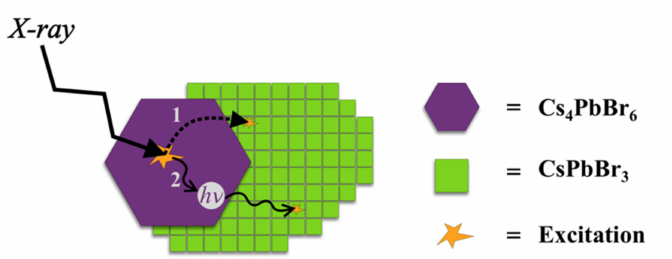
Figure 4. Schematic illustration of the energy-transfer hypothesis; path 1 : non-radiative energy transfer from Cs 4 PbBr 6 excited state to the excited state of neighboring CsPbBr 3 nanocrystal; path 2 : radiative energy transfer, ultraviolet photon emitted by scintillation process in Cs 4 PbBr 6 is absorbed by CsPbBr 3